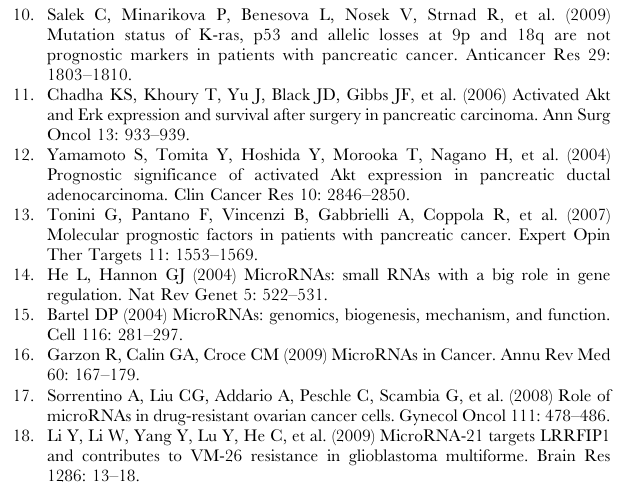
Table S2 Adjuvant therapy regimens.